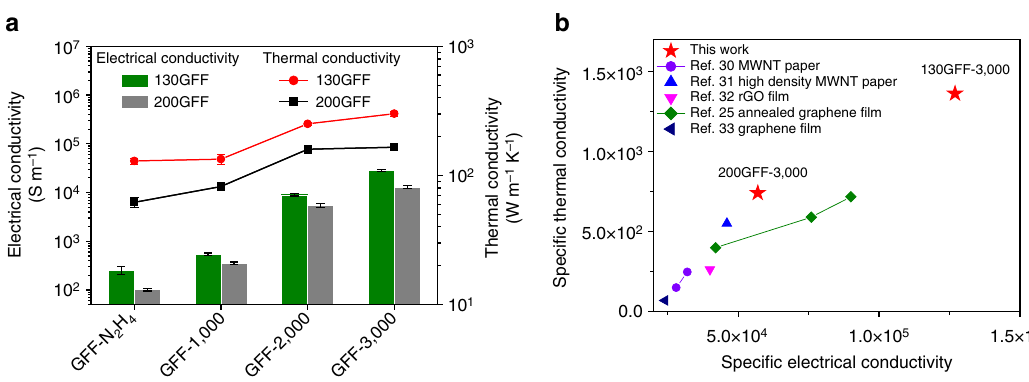
Figure 4 | Electrical and thermal conductivities of GFFs. ( a ) In-plane electrical and thermal conductivities of 130GFFs and 200GFFs after N 2 H 4 reduction and thermal annealing at various temperatures. Error bars represent the s.d. of the conductivities of different GFFs. ( b ) Comparison of specific electrical conductivity ( s / r ) and specific thermal conductivity ( k / r ) of GFFs with selected 2D assemblies of carbon nanotube (CNT) or graphene. The units for s , k and r are Sm (cid:3) 1 , Wm (cid:3) 1 K (cid:3) 1 and gcm (cid:3) 3